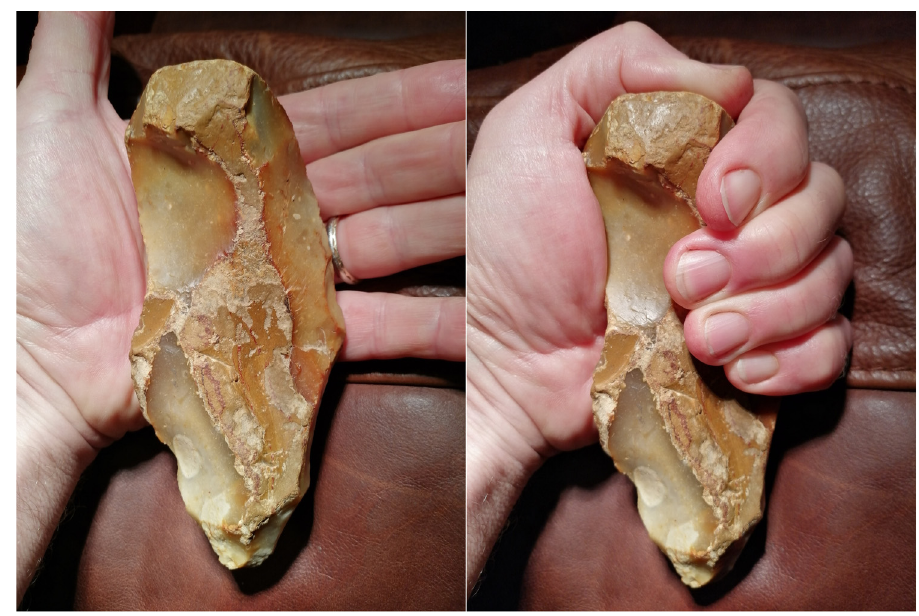
Figure 3: Mesolithic “ pick, ” 140 mm × 65 mm, 300 g, fl int ( Anonymous, c. 10000 – 4000 BCE )